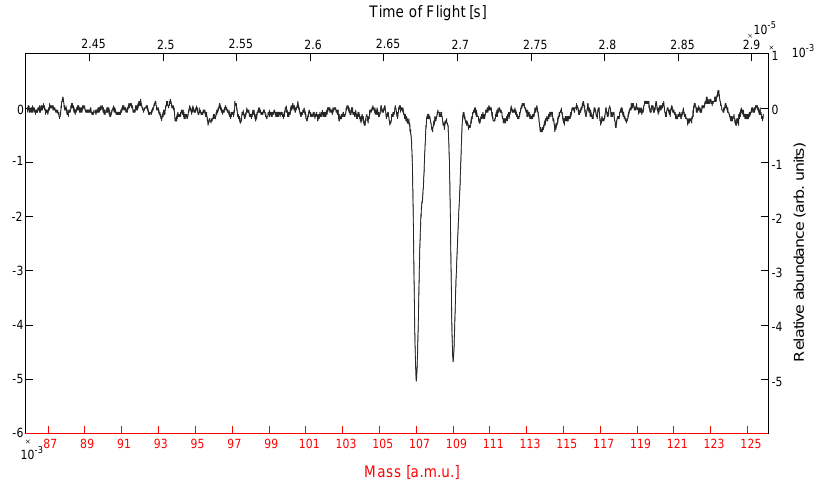
Figure 4. Detected TOF signal of Ag. The signal is plotted against time (upper x-axis) and against mass (lower x-axis).